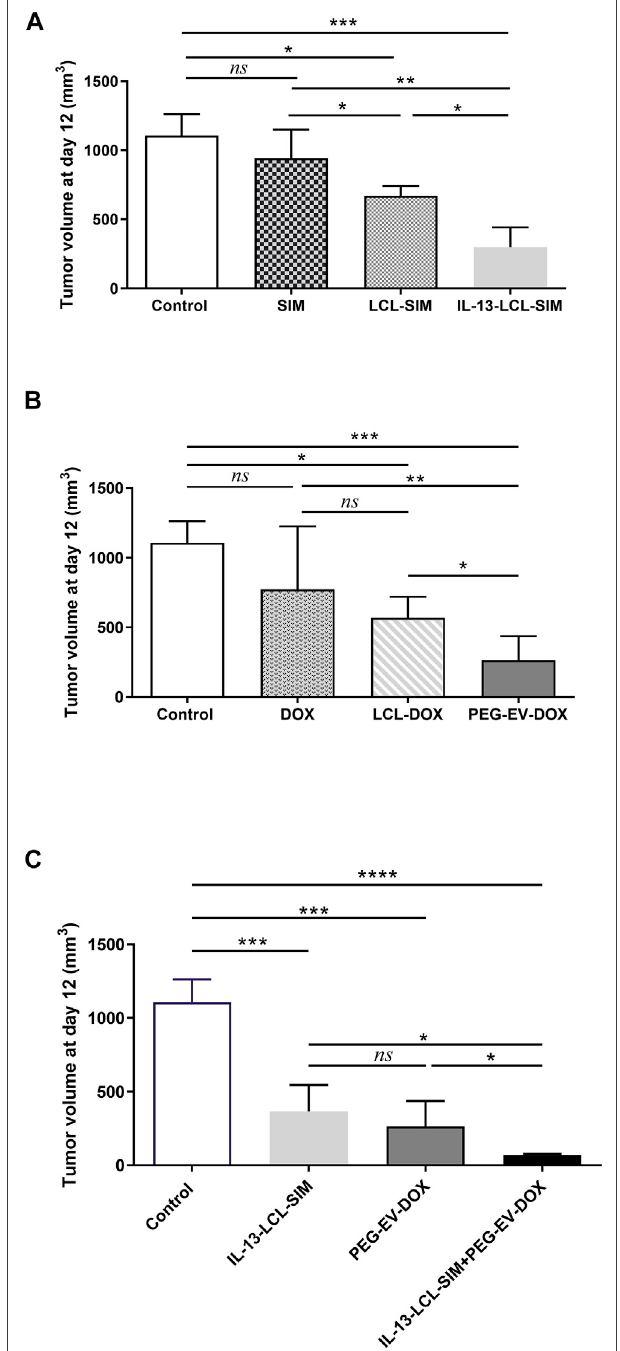
FIGURE 3 | Effects of different treatments on tumor growth. Tumor volumes after different treatments at day 12 (when mice were euthanized) are showninpanels (A – C) .Experimentalgroups( n =5)receivedtwo i.v .injections containing (A) 5 mg/kgSIMinfreeformandencapsulatedinLCL-SIMor IL-13-LCL-SIM on days 7 and 10 after melanoma cell inoculation and (B) 2 mg/kg DOX in free form or incorporated in LCL-DOX or PEG-EV-DOX on